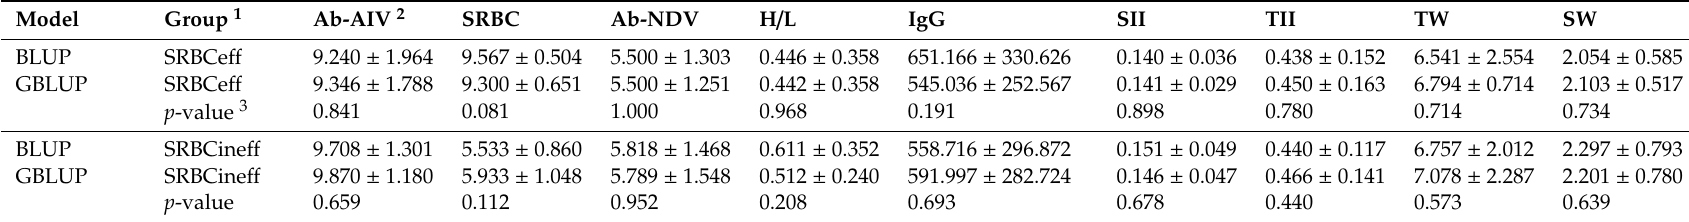
Table 5. Mean and standard deviation of breeding values of various traits predicted from the two methods for birds with low or high SRBC. Model